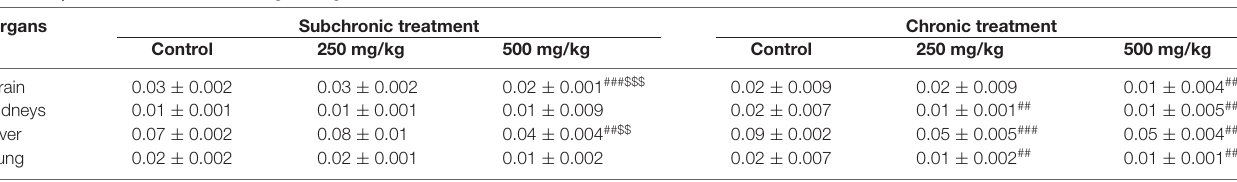
TABLE 2 | Effect of GBH on relative organ weight.